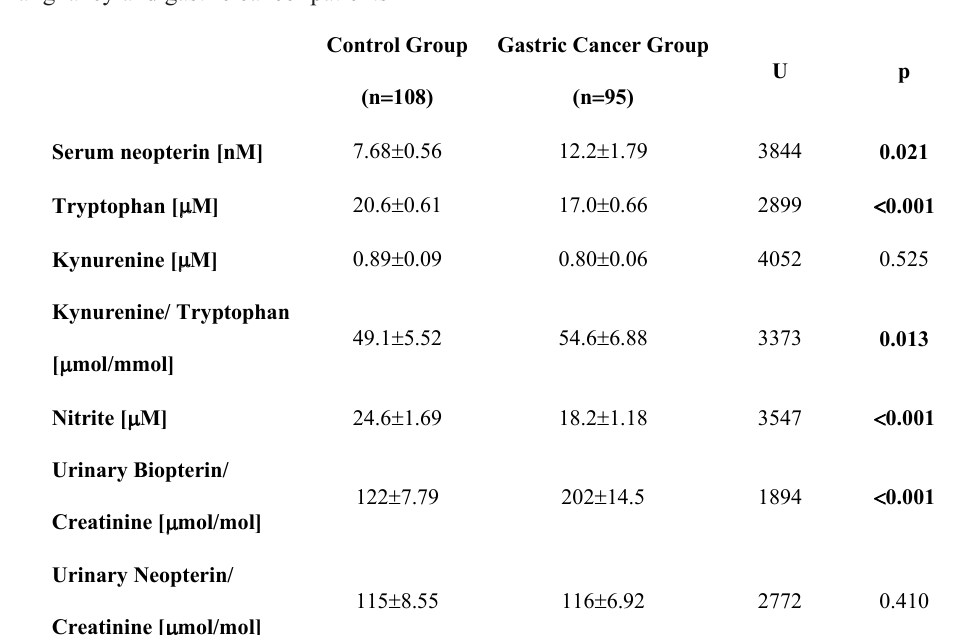
Table 1. Comparison of neopterin, tryptophan, kynurenine, nitrite, biopterin levels [mean ± SEM] of controls with- out malignancy and gastric cancer patients